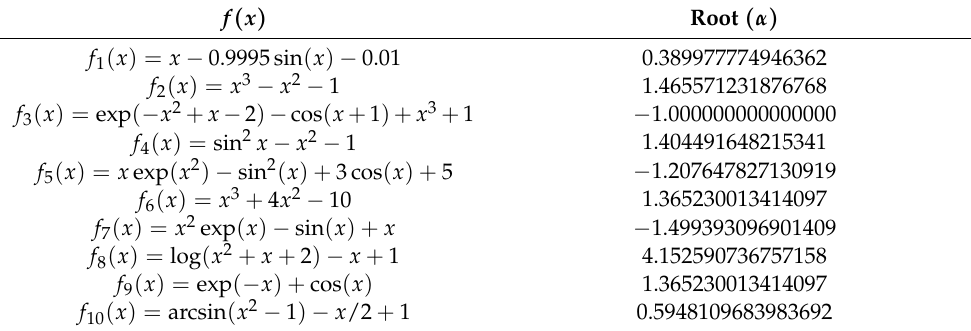
Table 1. Test Functions.